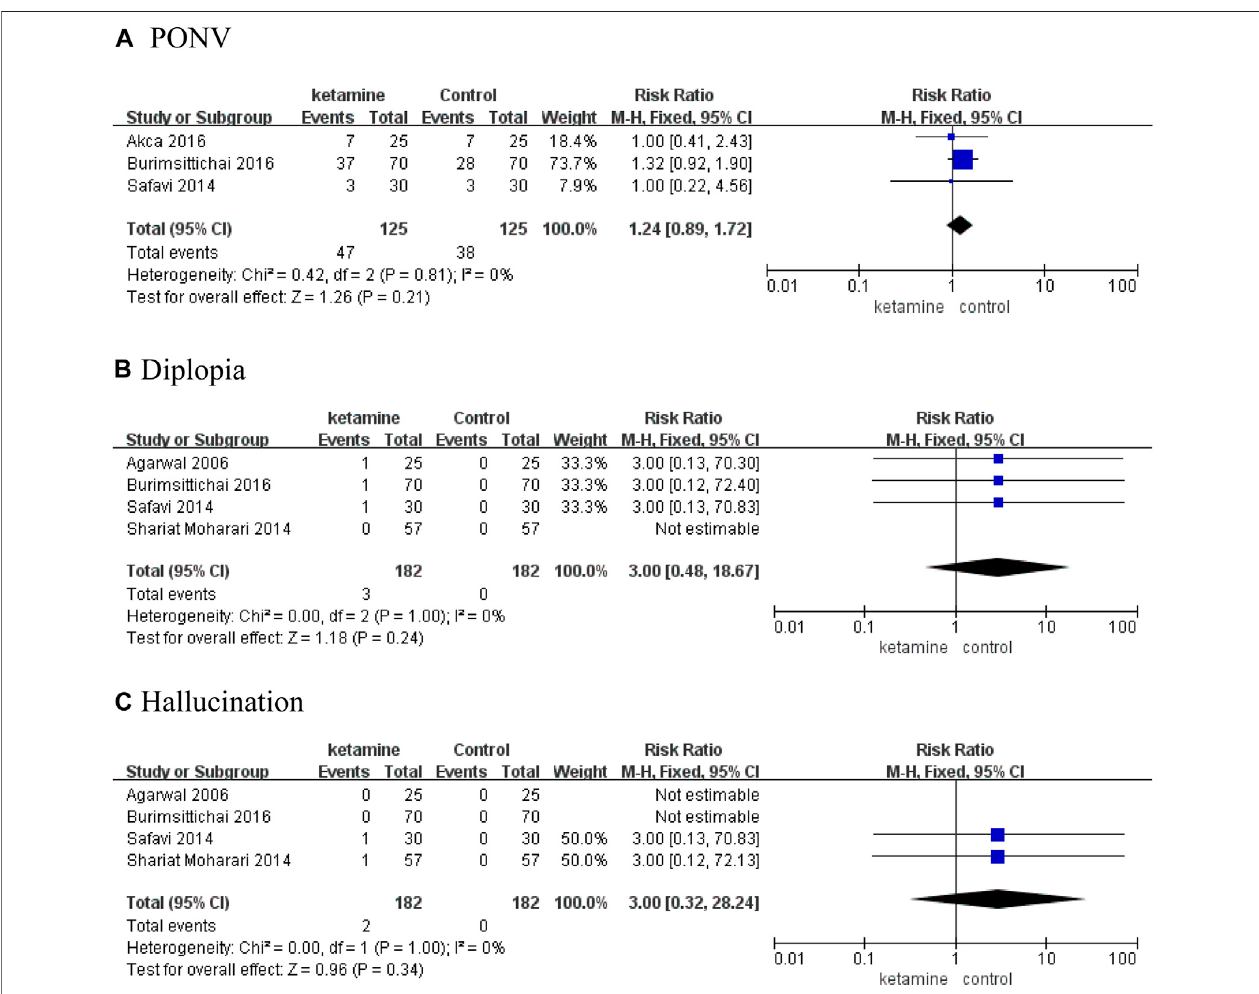
FIGURE 6 | Forest plot of adverse events. (A) PONV. (B) Diplopia. (C)